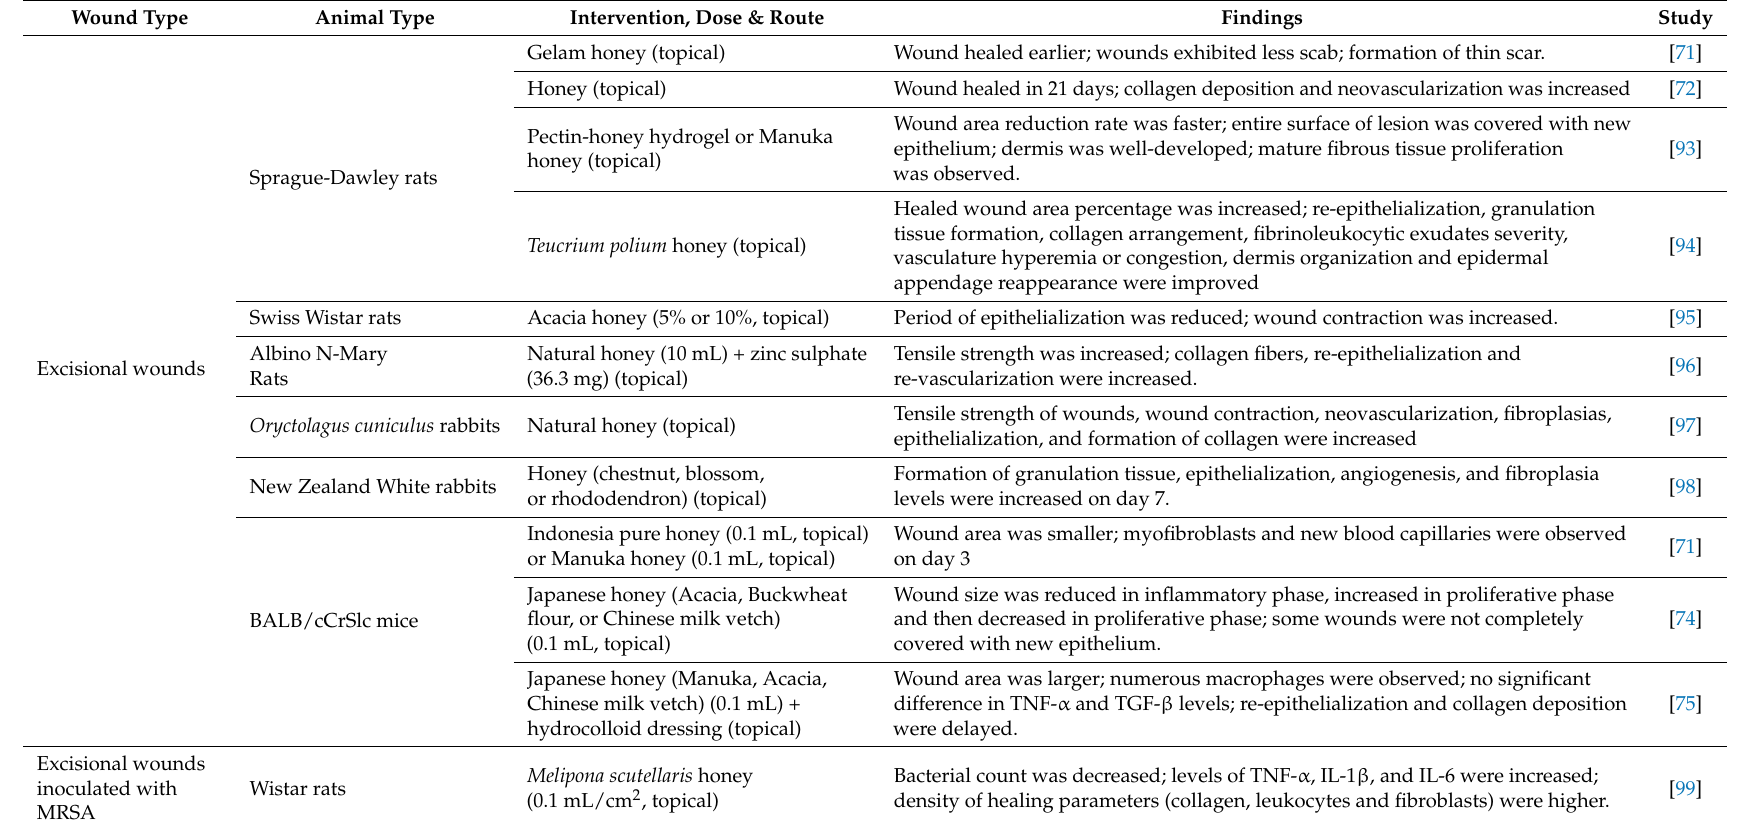
Table 3. The effects of honey on wound healing in animal